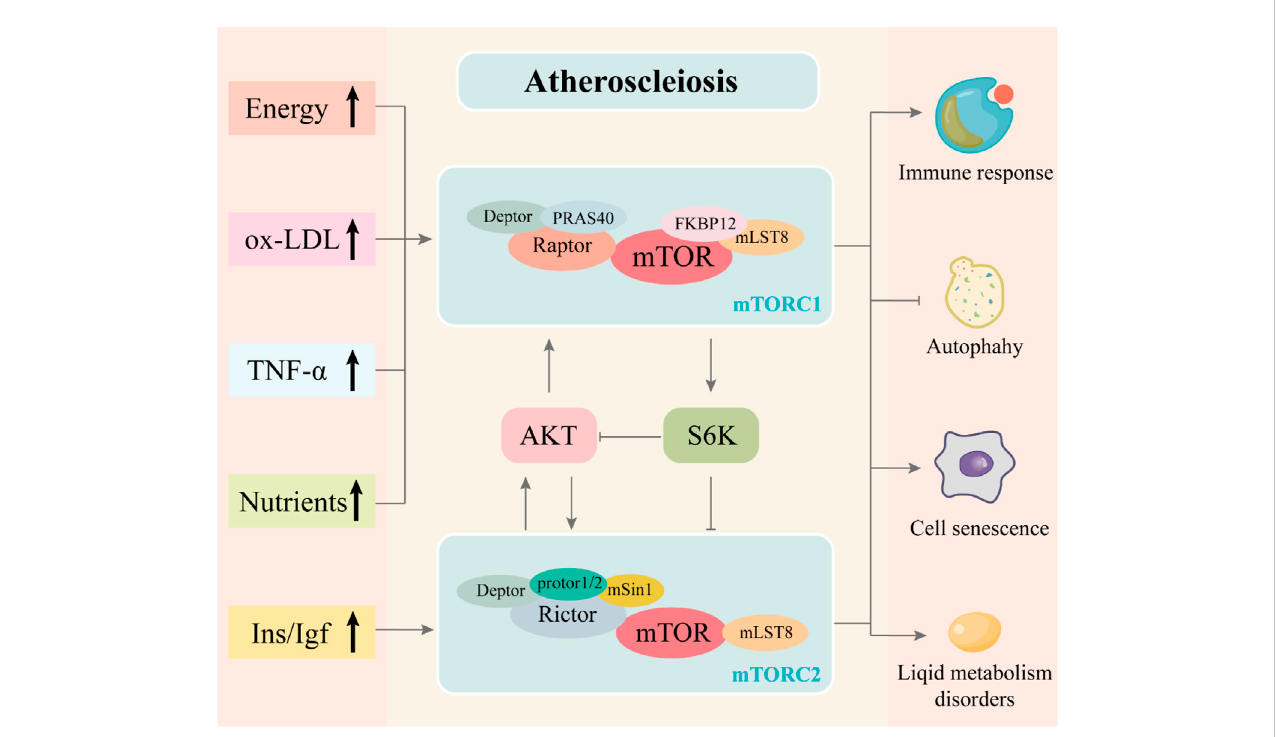
FIGURE 2 Association of mTOR signaling pathway with AS and the composition of the mTORC1 and mTORC2 complexes. The mTORC1 complex is composed of mTOR, Raptor, mLST8, PRAS40, Deptor and FKBP12. The mTORC2 complex is composed of mTOR, Rictor, mLST8, protor1/2, Deptor and mSin1. The mutual regulation is between mTORC1 and mTORC2. The development of atherosclerosis is often accompanied by abnormal lipid and energy metabolism and increased in fl ammatory response, whichmay activate themTOR signaling pathway throughcomplexmechanisms. These stimuli, as upstream signals of the mTOR signaling pathway, regulate the activity of the mTORC1 and mTORC2 complexes in the mTOR signaling pathway and in fl uence downstream regulation, producing effects that promote immune response and cell senescence, disrupt lipid metabolism and inhibit autophagy, thereby exacerbating